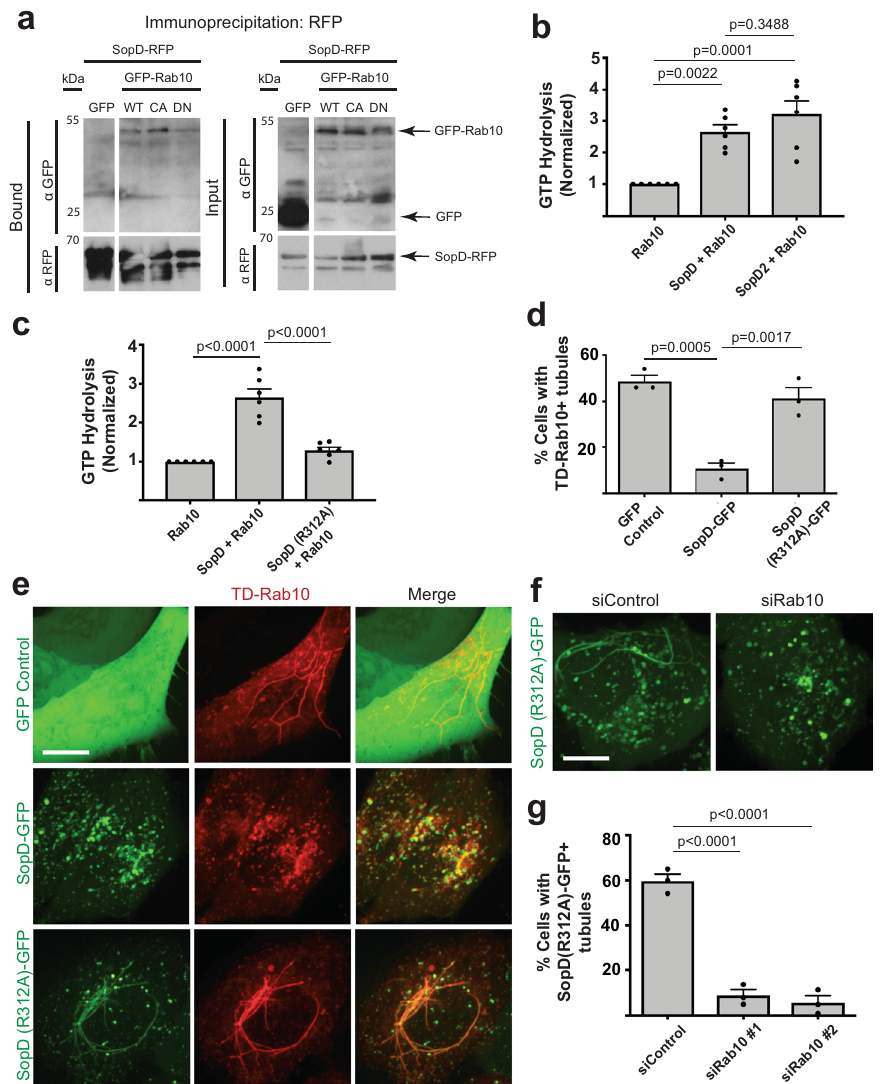
Fig. 1 SopD is a bacterial GAP for Rab10. a Co-immunoprecipations. HEK923T cells were co-transfected with SopD-RFP and GFP-Rab10 variants, and lysates were precipitated with anti-RFP-Trap af fi nity resin. Western blot analysis was performed on elutions. b Puri fi ed Rab10 (8 µ M) was incubated alone and with SopD or SopD2 (8 µ M). GTP hydrolysis as measured by a malachite green assay, is represented relative to Rab10 alone. GTP hydrolysis was measured as indicated in the Methods section. Values represent relative GTP hydrolysis and are the mean ± S.E.M. of six technical replicates from three independent determinations with multiple protein preparations. Statistical analysis was performed with a one-way ANOVA. c Puri fi ed Rab10 was incubated alone, with SopD or the SopD catalytic mutant (R312A) (8 µ M) and the GTP hydrolysis is represented relative to Rab10 alone. GTP hydrolysis was measured as indicated in the Methods section. Values represent relative GTP hydrolysis and are the mean ± S.E.M. of 6 technical replicates from three independent determinations with multiple protein preparations. Statistical analysis was performed with a one-way ANOVA. d Quanti fi cation of the number of Henle 407 cells co-transfected with TD-Rab10 and GFP control, SopD, or SopD(R312A)-GFP tagged constructs that have TD-Rab10 + tubules. In three independent experiments at least 50 cells were scored for the presence or absence of TD-Rab10 + tubules. Data are means± S.E.M. Statistical analysis was performed with a one-way ANOVA. e Representative images of Henle 407 cells co-transfected with TD-Rab10 and GFP control, SopD, or SopD(R312A)- GFP tagged constructs from ( d ). Scale Bar, 15 μ m. f Representative images of Henle 407 cells that were transfected with Control siRNA or Rab10 siRNA #1 (see methods) and then SopD(R312A)-GFP 24 h later. Scale Bar, 15 μ m. g Henle 407 cells were transfected with either Control siRNA, Rab10 siRNA #1 or Rab10 siRNA #2 (see “ methods ” ) and then SopD(R312A)-GFP 24 h later. Data represent quanti fi cation of the number of transfected cells with SopD (R312A) + tubules. In three independent experiments at least 100 cells were scored. Data are means ± S.E.M. Statistical analysis was performed with a one- way ANOVA. Images are representative of at least three independent experiments. SCV Salmonella -containing vacuole, WT wild type, CA constitutively active, DN dominant negative, RFP red fl uorescent protein, GFP green fl uorescent protein, TD TdTomato. Source data are included in source data fi le. whether SopB promotes recruitment of Rab10 as well. The S . Supplementary Fig. 6). Complementation of the Δ sopB bacteria Typhimurium mutant strain lacking SopB ( Δ sopB , deleted for the with WT SopB, but not the catalytically inactive C462S mutant 31 , expressed from a low copy plasmid restored recruitment of GFP- sopB gene) had a signi fi cant defect in Rab10 recruitment to the Rab10 to invasion sites at 10 min p.i. (Fig. 2a, b). These data invasion site relative to WT 10 min p.i. (Fig. 2a, b), but these suggest that Rab10 localization kinetics at S . Typhimurium bacteria eventually colocalized with Rab10 by 30 min p.i. (Fig. 2d, NATURE COMMUNICATIONS| (2021) 12:4707